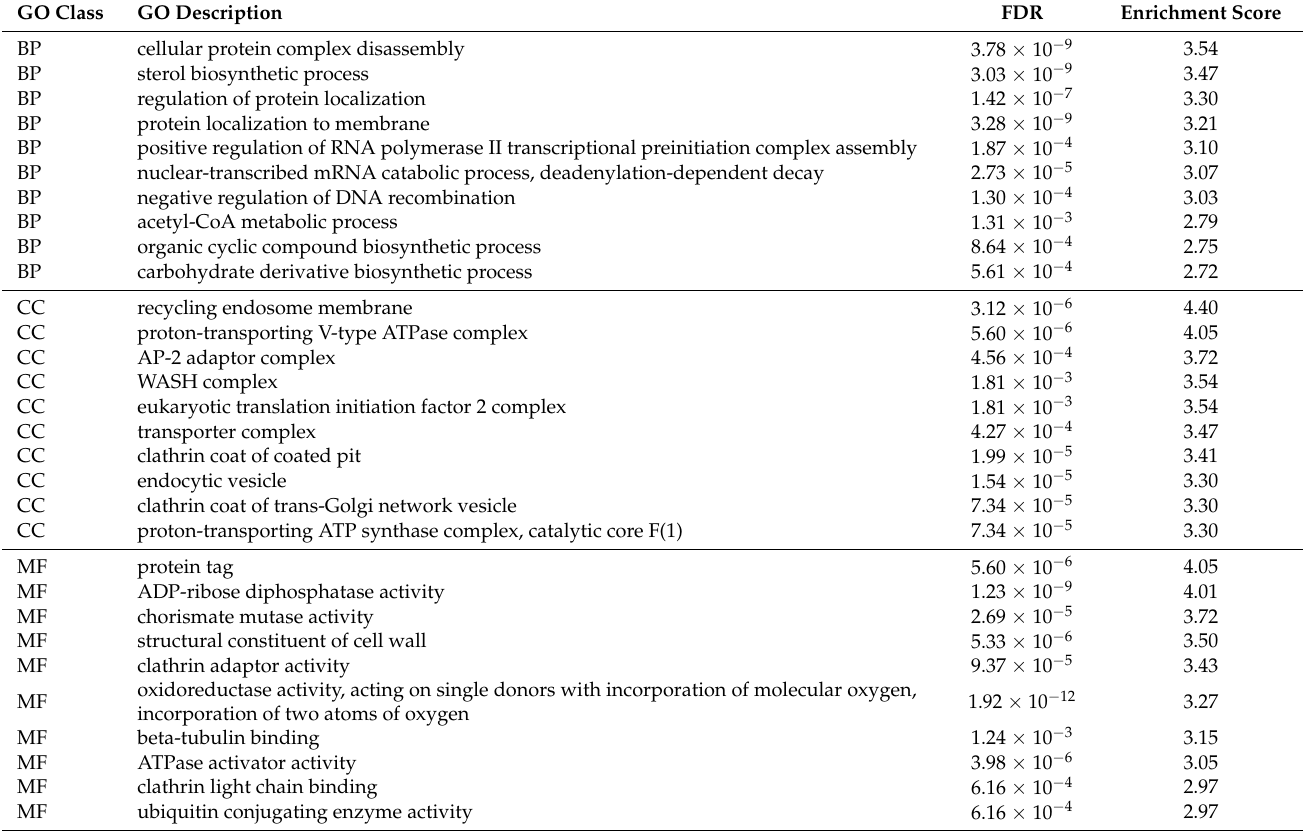
Table 1. The top ten gene ontology (GO) categories in biological processes (BPs), cellular component (CC) and molecular function (MF) in the upregulated group of transcripts at 6